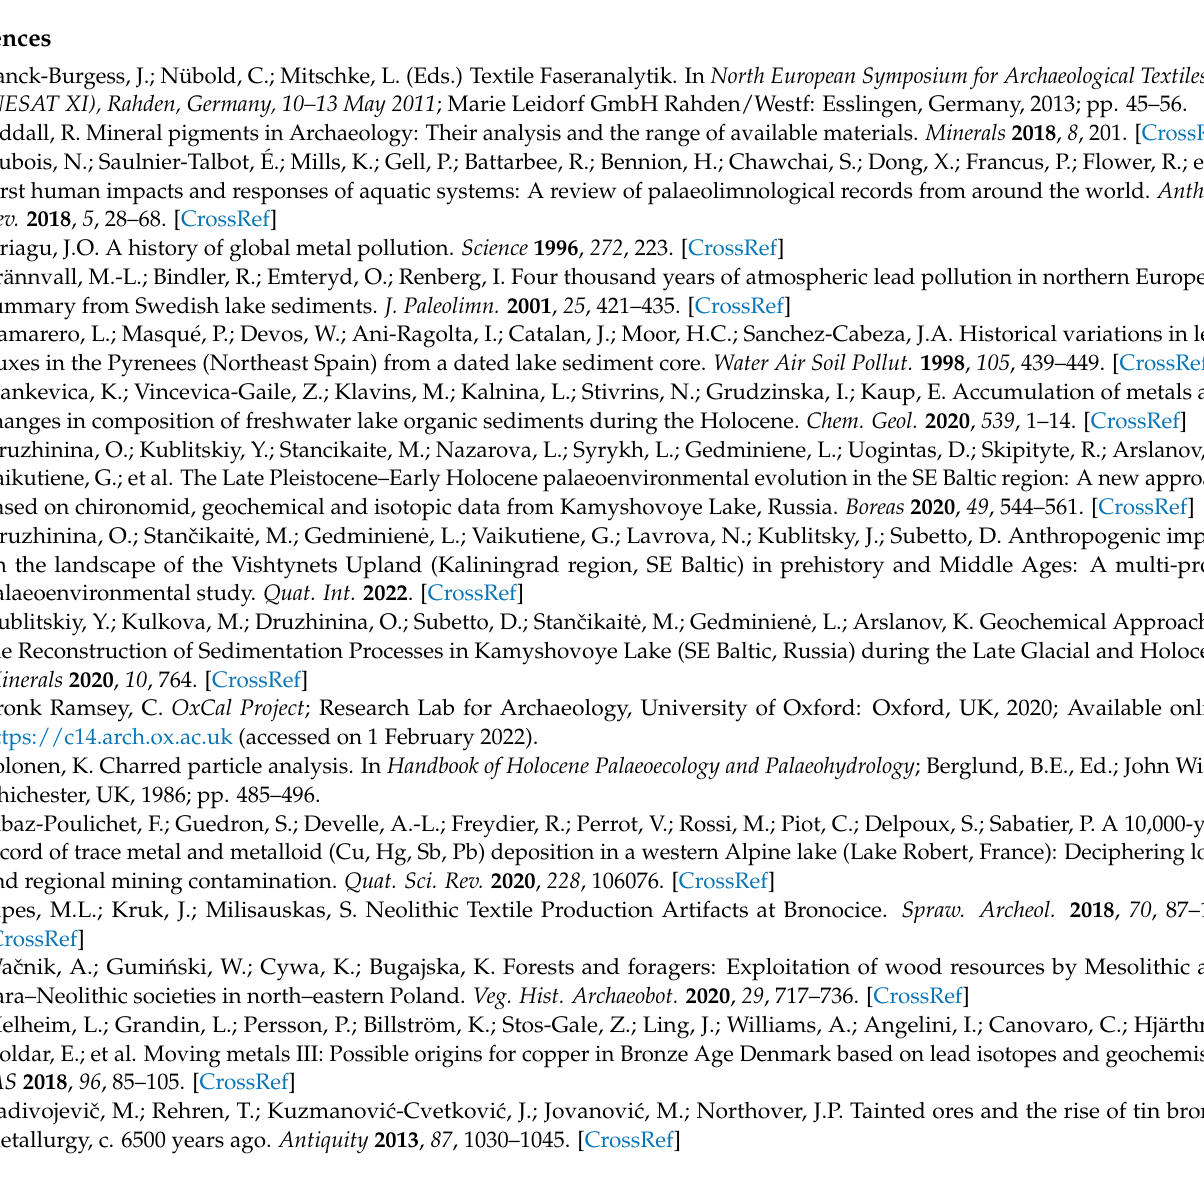
Figure S3: Box and whisker plot, mean values, SE and